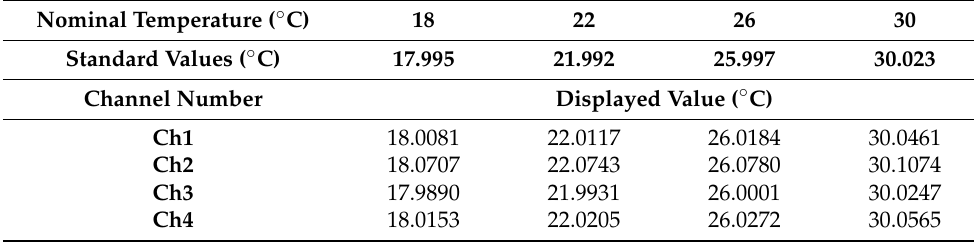
Table 1. Thermometer calibration